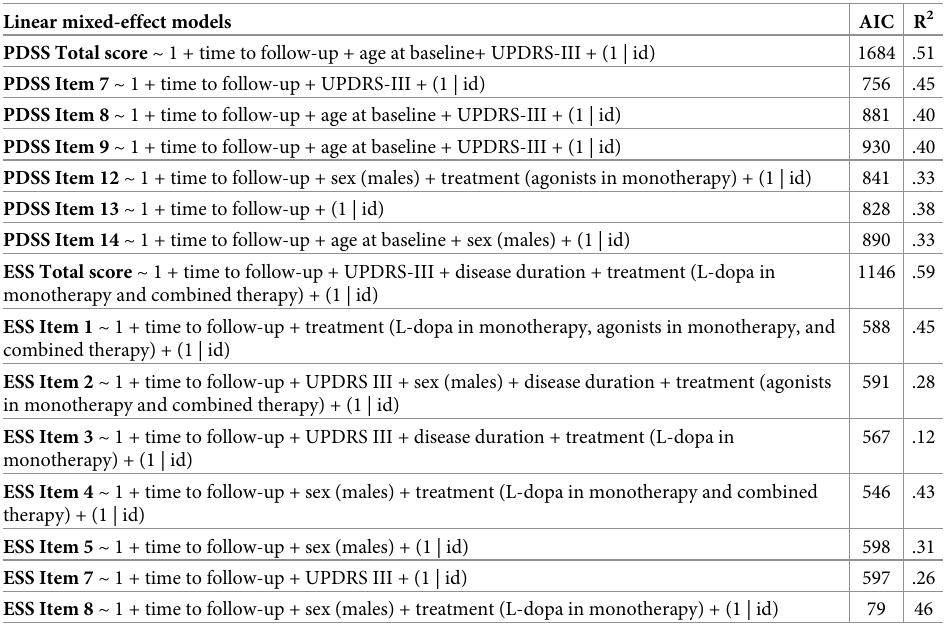
Table 3. Linear mixed-effect models selected with the lowest AIC value. Linear mixed-effect